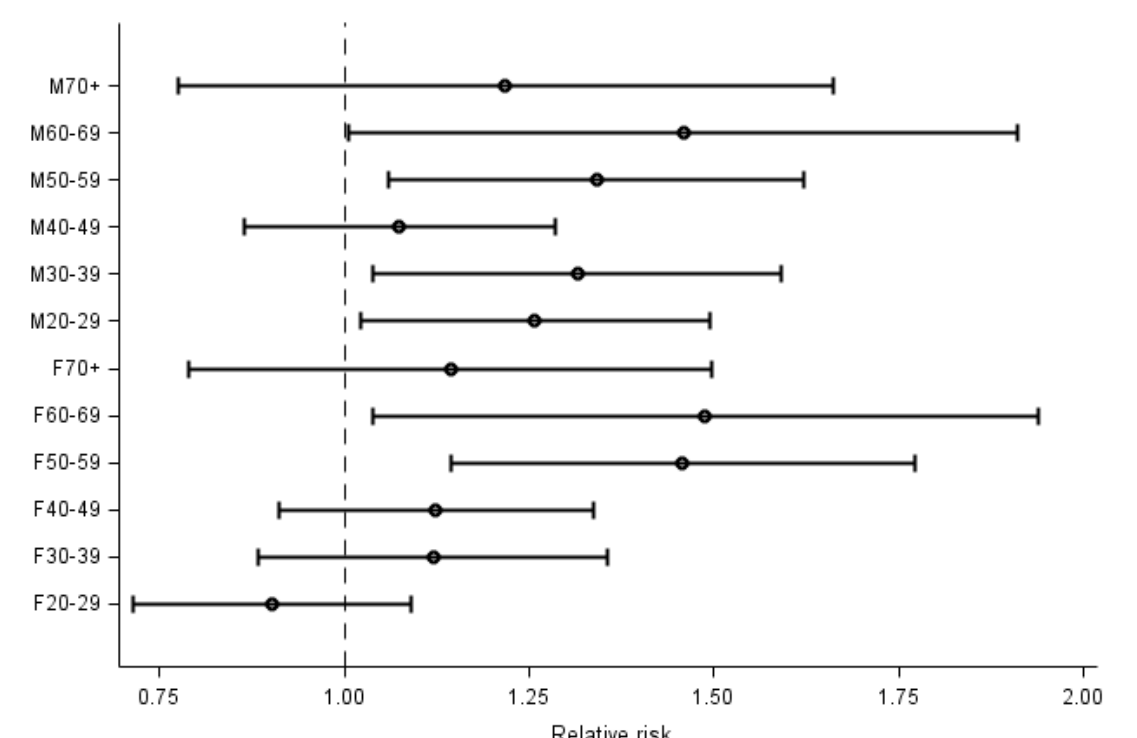
Figure 2. Stratum-specific relative risks and associated 95% confidence intervals of verified COVID-19 in Ronneby (all districts together) in relation to the reference town.